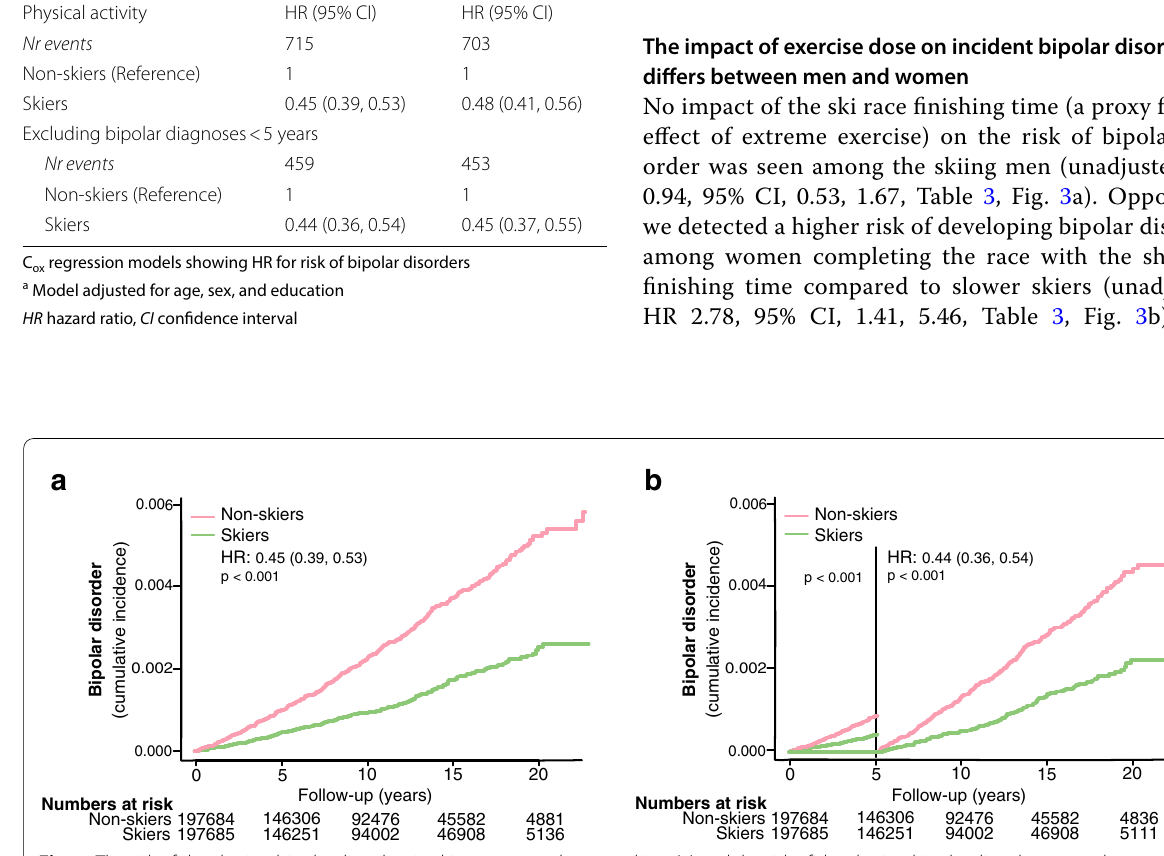
Table 2 Association between physical activity and incident bipolar disorders, based on participation in a long-distance ski race (skiers) compared to non-skiers